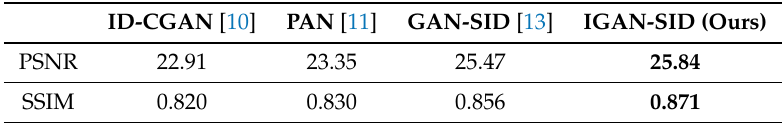
Table 3. Quantitative results on ID-CGAN dataset .